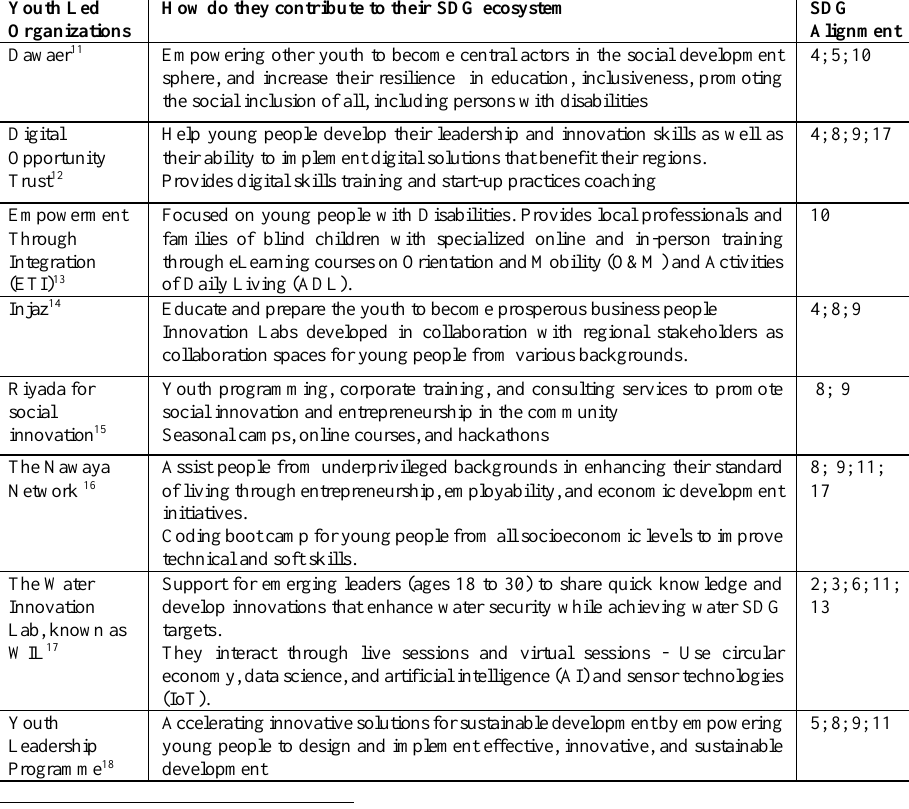
Table 2. Illustrative Cases in Youth Led Organizations and their Contribution to